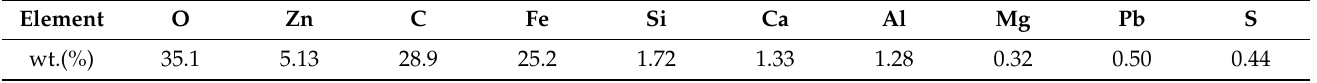
Table 3. The elemental analysis of the utilized blast furnace